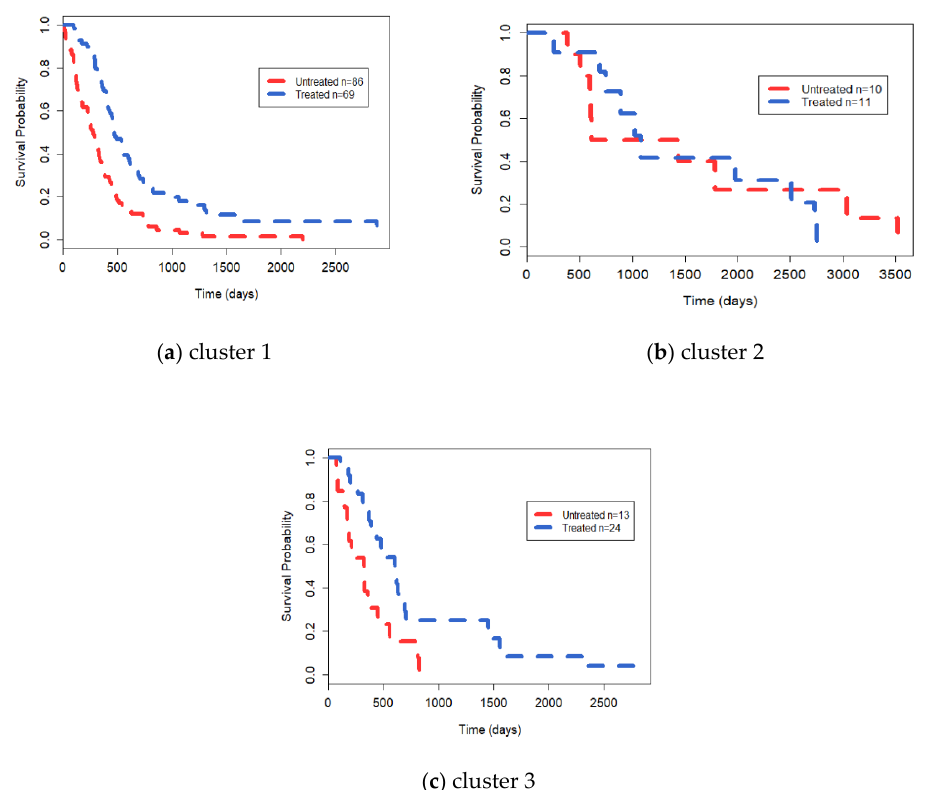
Figure 4. The Kaplan–Meier survival curves of the identified clusters ( a ): cluster 1, ( b ): cluster 2 and ( c ): cluster 3) of Temozolomide (TMZ) response. “Untreated” expresses the group which did not receive TMZ treatment and “Treated” expresses the group which received TMZ treatment.